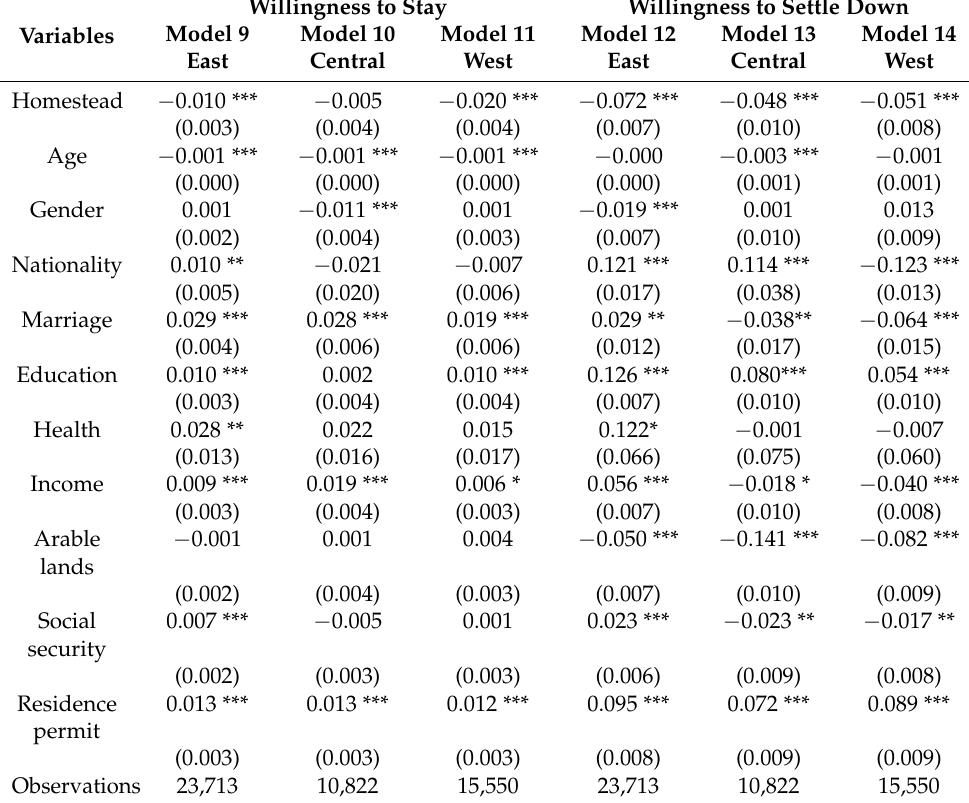
Table 5. Regression results by region (average marginal